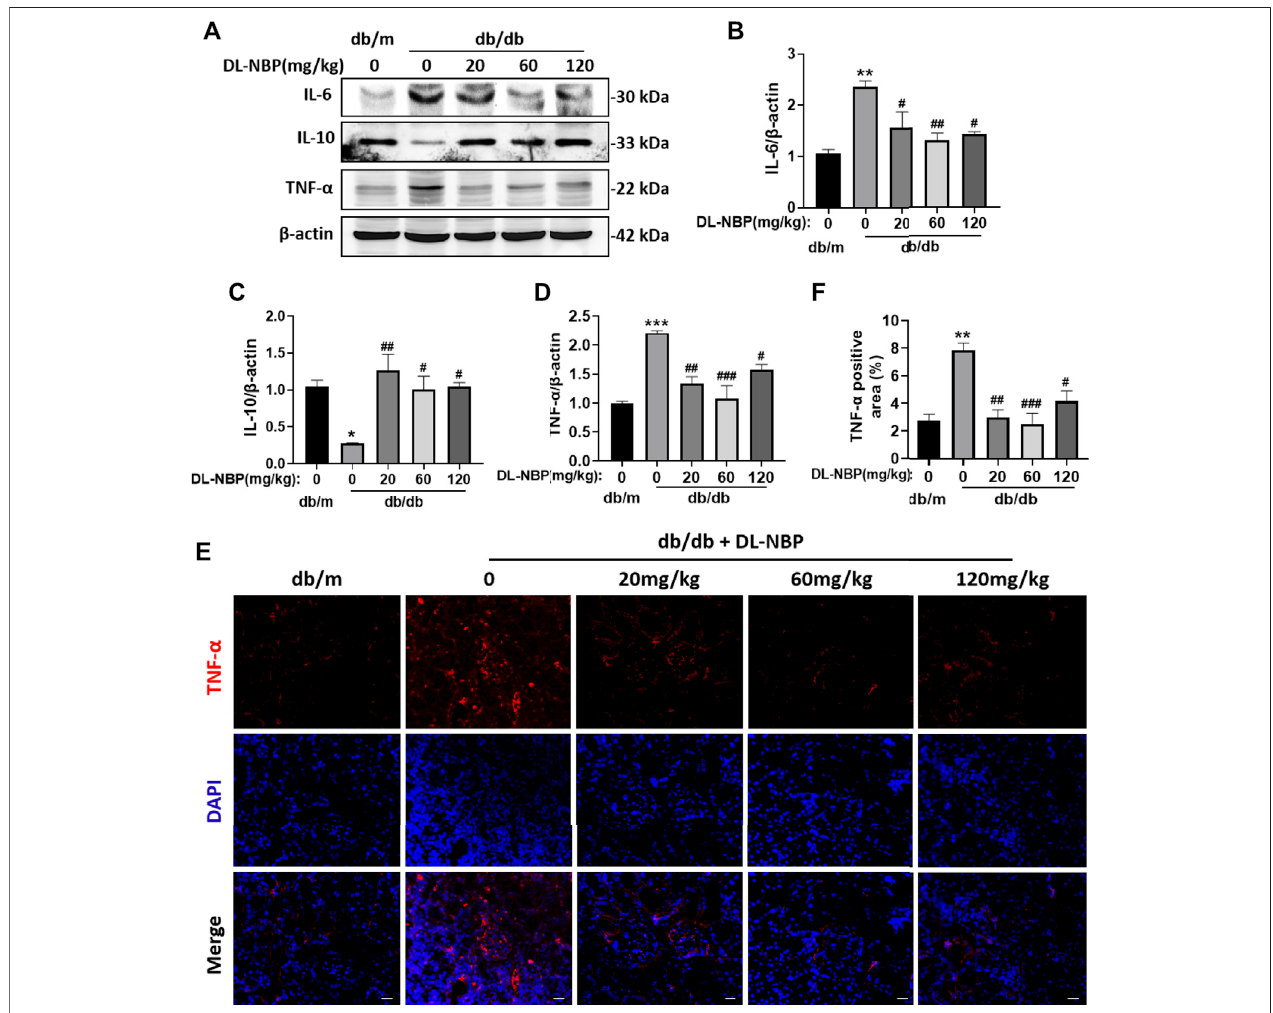
FIGURE 4 | DL-NBP prevents diabetes-induced excessive in fl ammation in kidney . (A – D) Western blotting and quanti fi cation of IL-6, IL-10 and TNF- α in kidney of mice from each group ( n (cid:2) 3). Protein expression was normalized to the expression of β -actin. (E,F) The immuno fl uorescence staining and quanti fi cation (original magni fi cation × 400)ofTNF- α inkidneyofmicefromeachgroup( n (cid:2) 3).Scalebar (cid:2) 20 μ m.Alldataarepresentedasthemean ± SEM.* p < 0.05,** p < 0.01,*** p < 0.001 vs. db/m control; # p < 0.05, ## p < 0.01, ### p < 0.001 vs. db/db